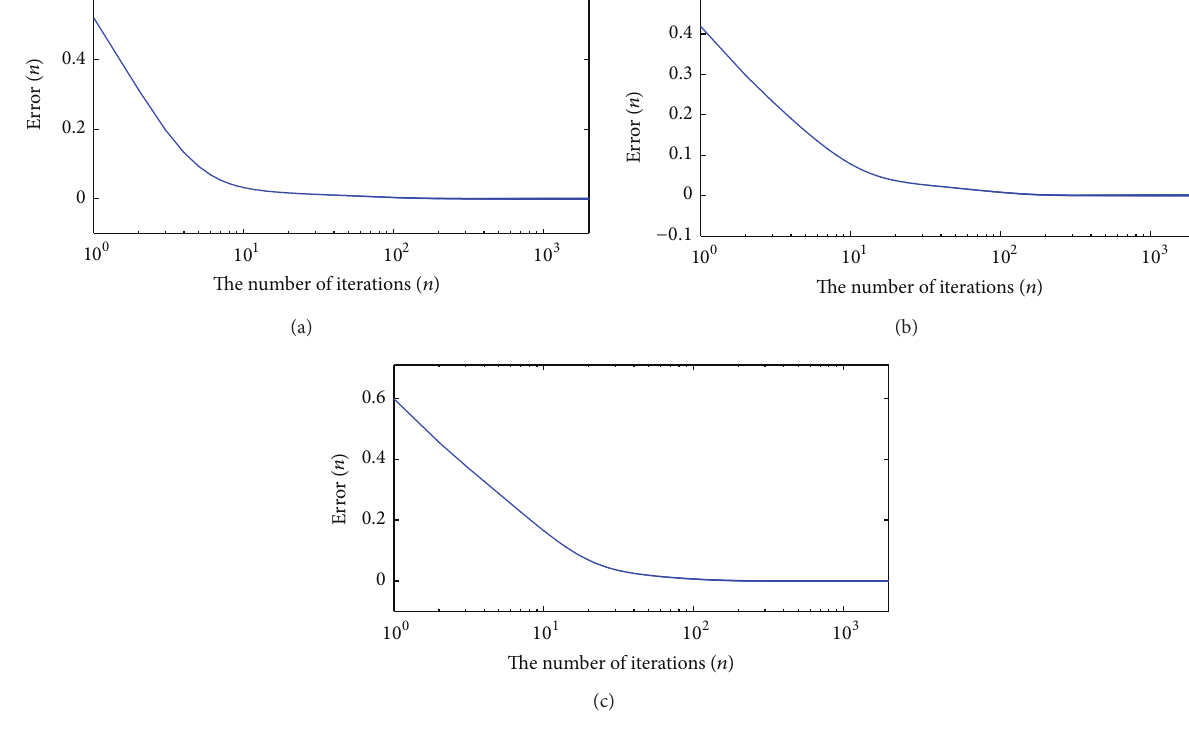
Figure 7: Errors between the exact solutions and iterative solutions.